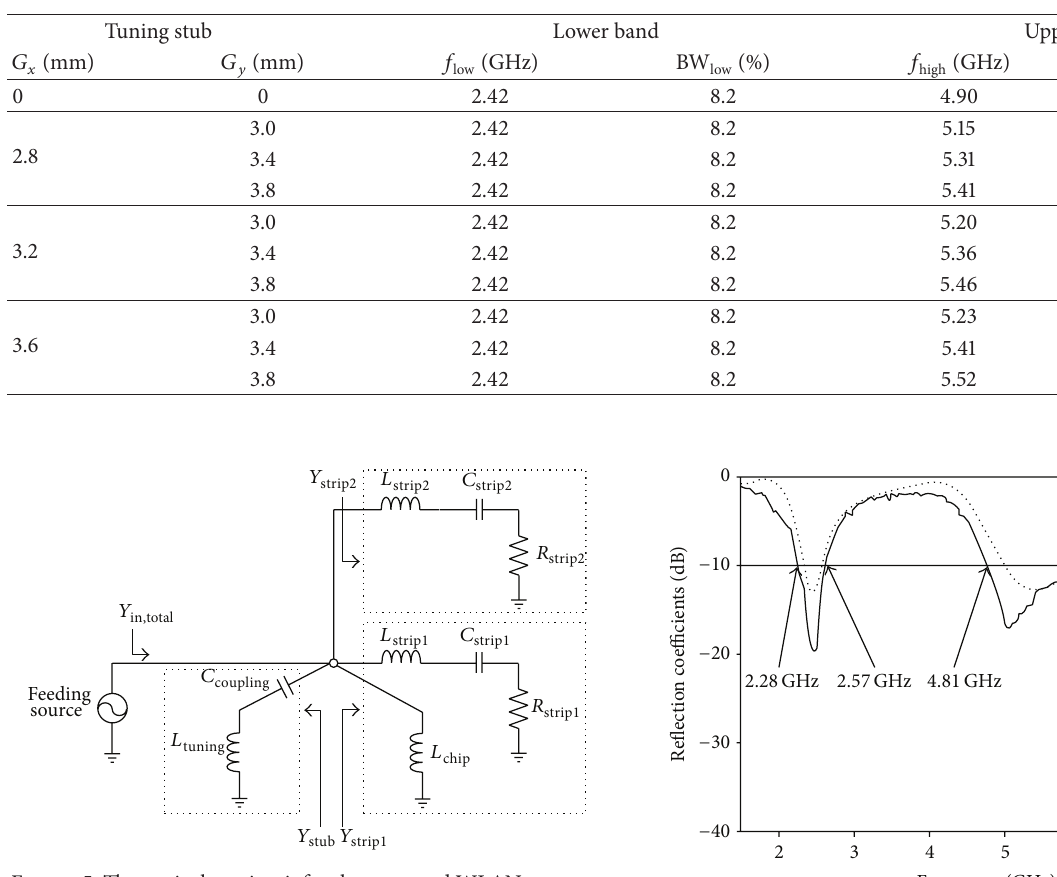
Table 1: Resonant frequency and 10-dB bandwidth for different tuning stubs.